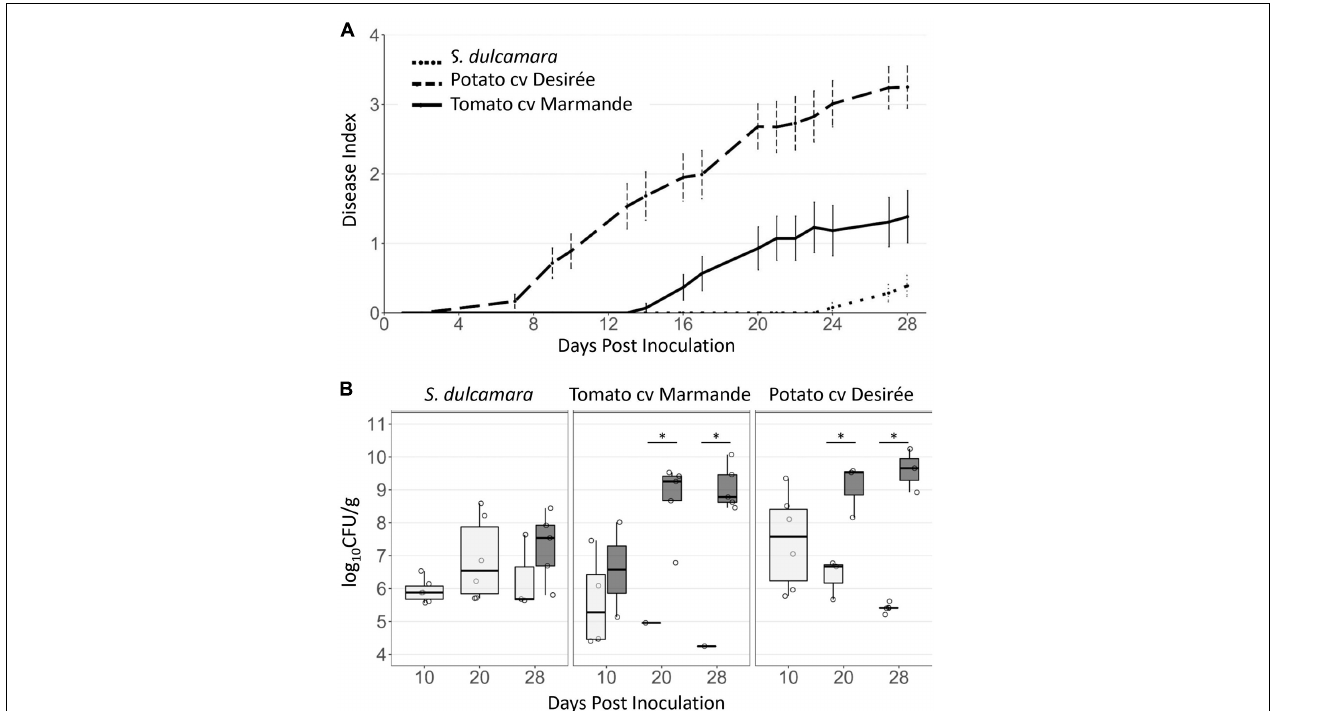
FIGURE 4 | Influence of temperature on bacterial wilt symptomatology in S. dulcamara and susceptible tomato and potato varieties. (A) Bacterial wilt symptom development (0 = asymptomatic to 4 = completely wilted) after soil-drench inoculation in S. dulcamara, tomato cv. Marmande and potato cv. Desirée plants inoculated with the R. solanacearum luminescent reporter and kept at 20 ◦ C. n = 30–35 plants per species. (B) Bacterial concentrations at the taproot level quantified by measuring the luminescence at 10, 20 and 28 dpi from S. dulcamara , susceptible tomato cv. Marmande, and susceptible potato cv. Desirée inoculated as in panel (A) . Results are grouped according to disease symptoms: asymptomatic (grey, disease index 0) and symptomatic (white, disease indices 1–4). n = 4–8 plants per sampling day and condition. ∗ indicates statistical differences ( p value < 0.05, T -student significant